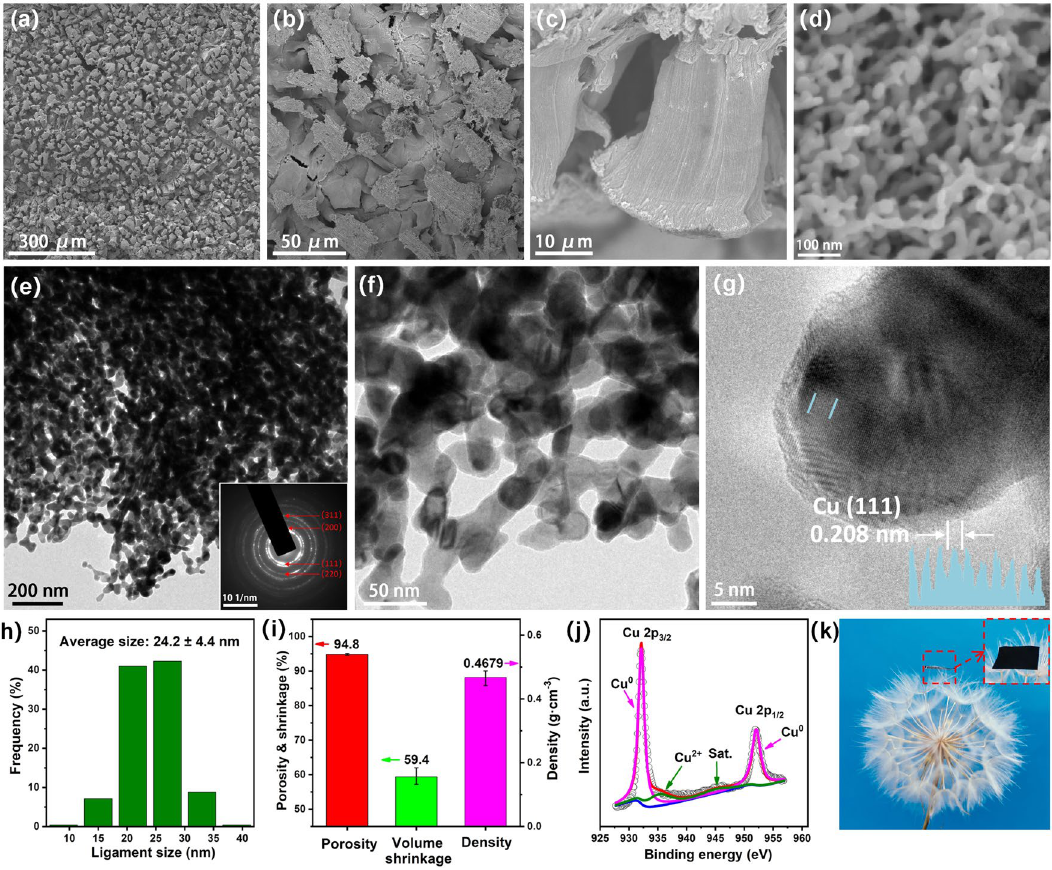
Fig. 4 a–d SEM images, e , f TEM images (Inset: SAED pattern), g HRTEM image, and h ligament size distribution of the NP-Cu film. i Sum- mary of porosity, volume shrinkage and density, j XPS spectrum of Cu 2 p , and k photograph of the NP-Cu